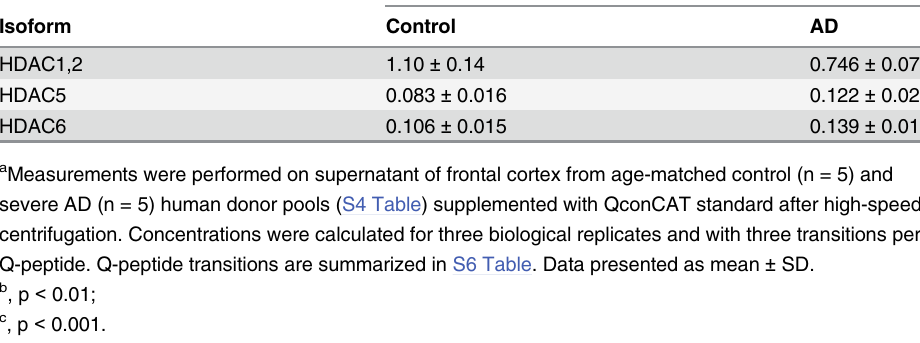
Table 1. Summary of human frontal cortex HDAC concentrations.